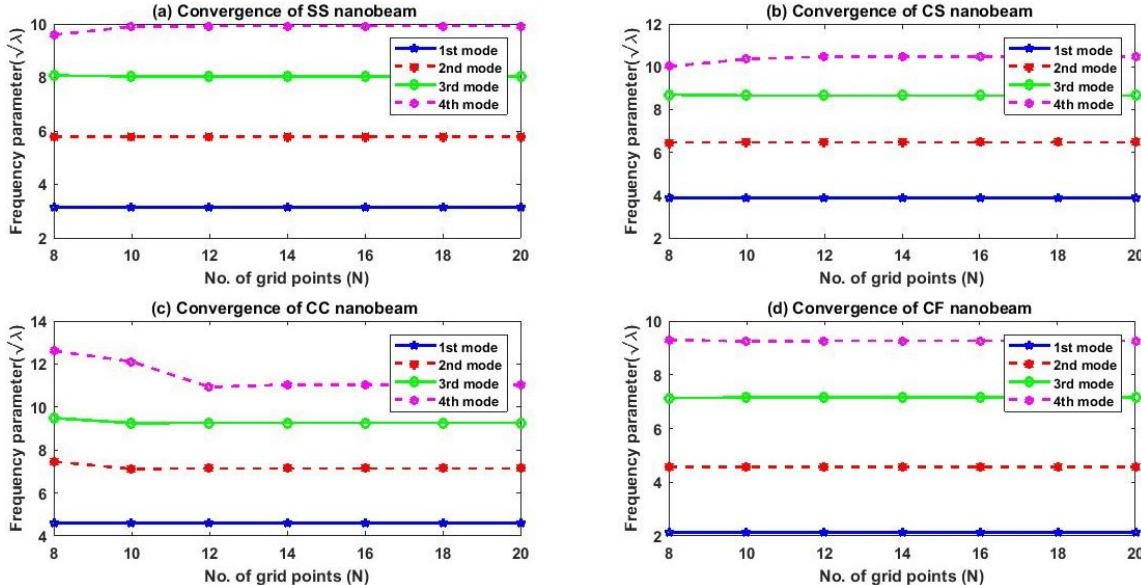
Figure 1: Variation of frequency parameters with number of terms for SS, CS, CC and CF conditions